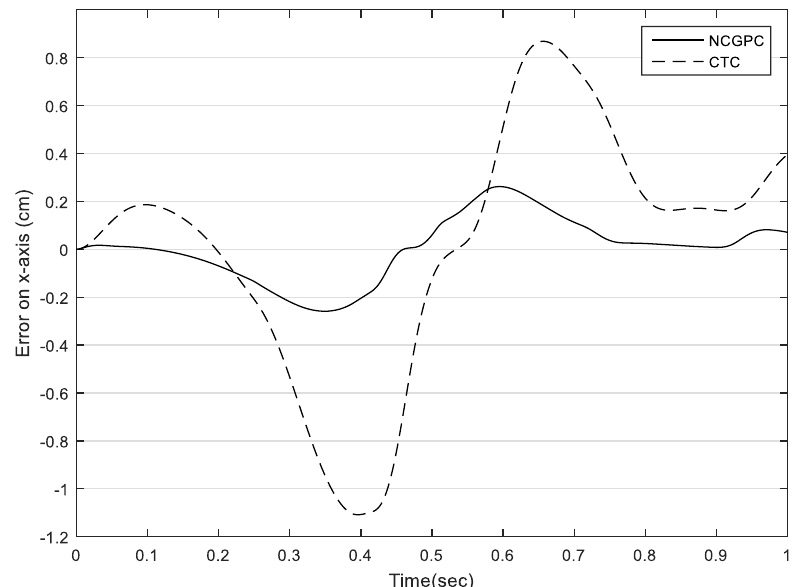
Figure 9. Position tracking errors along X-direction.